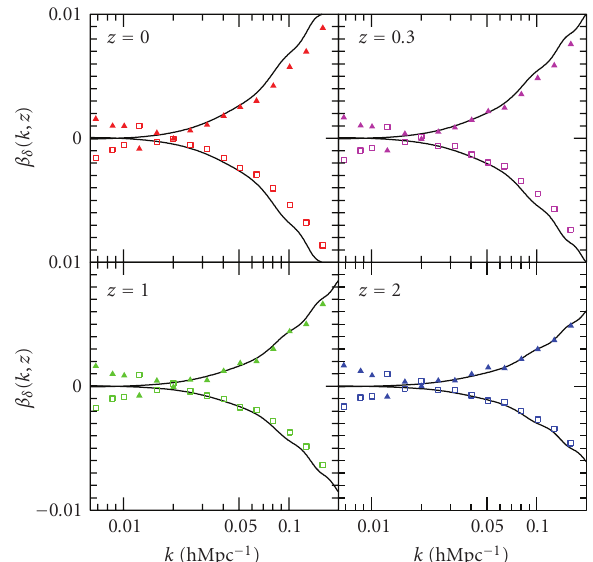
Figure 2: Non-Gaussian fractional correction β δ ( k , z ) = ( k , z ) /P G ( k , z ) to the matter power spectrum that originates Δ P NG δ δ from primordial non-Gaussianity of the local type. Results are = +100 (filled shown at redshift z = 0, 0.5, 1, and 2 for f loc NL = − 100 (empty symbols). The solid curves symbols) and f loc NL indicate the prediction from a 1-loop perturbative